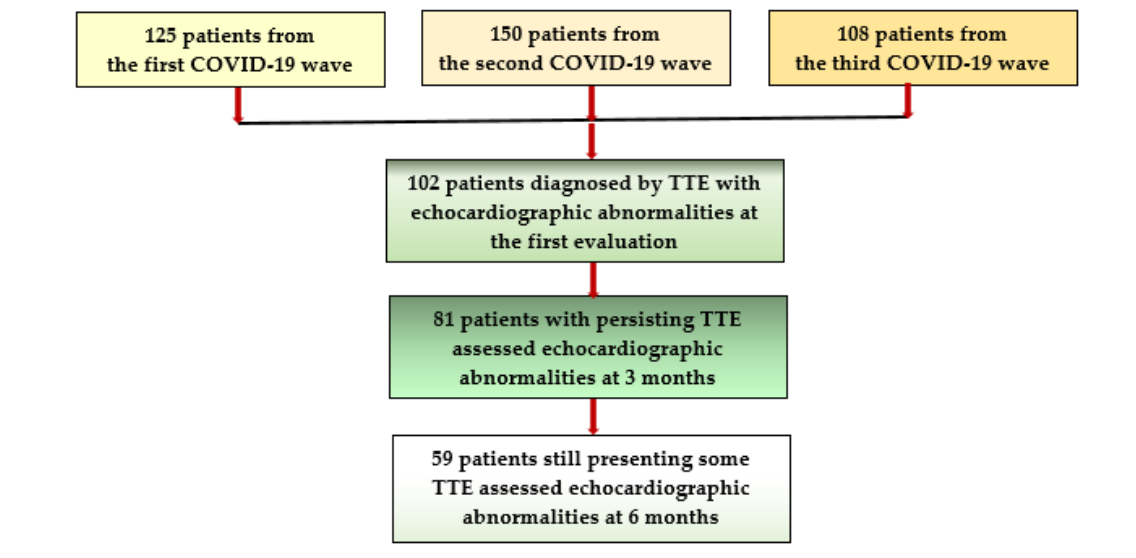
Figure 1. Flowchart of patient selection and follow-up.